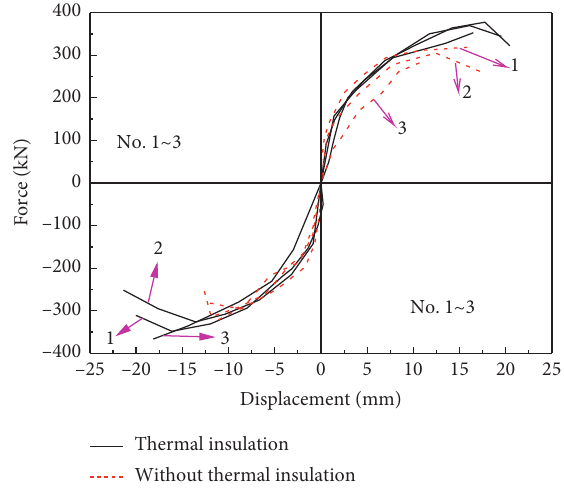
Figure 8: Comparison of skeleton curves.